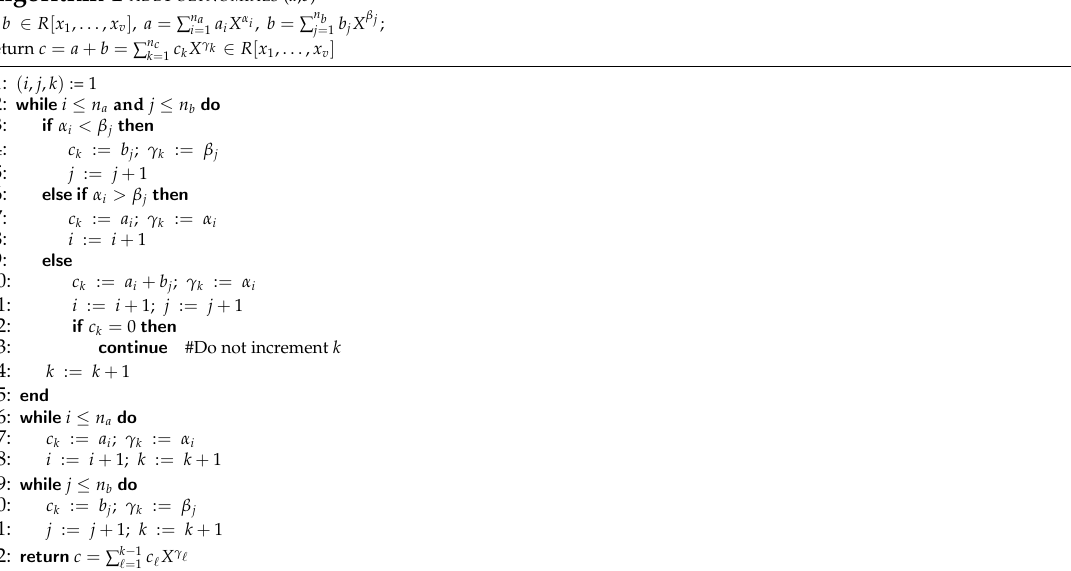
Algorithm 1 ADD P OLYNOMIALS ( a , b